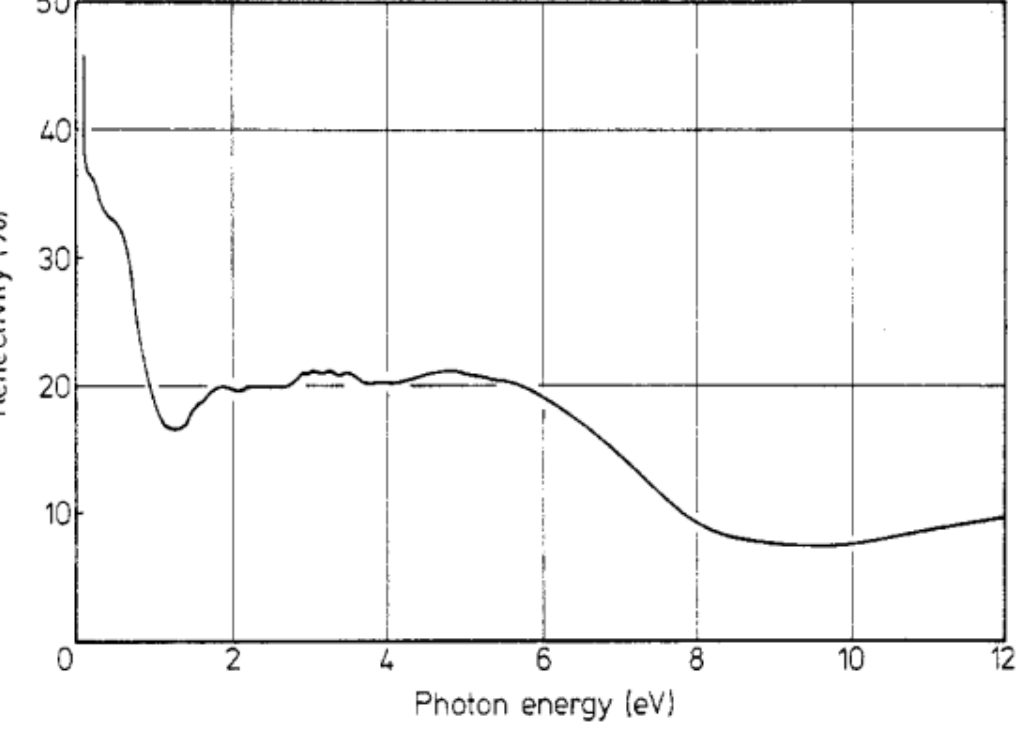
Figure 4. Reflectivity of Fe 3 O 4 at room temperature [14]. [Reflectivity of Fe 3 O 4 at room temperature.